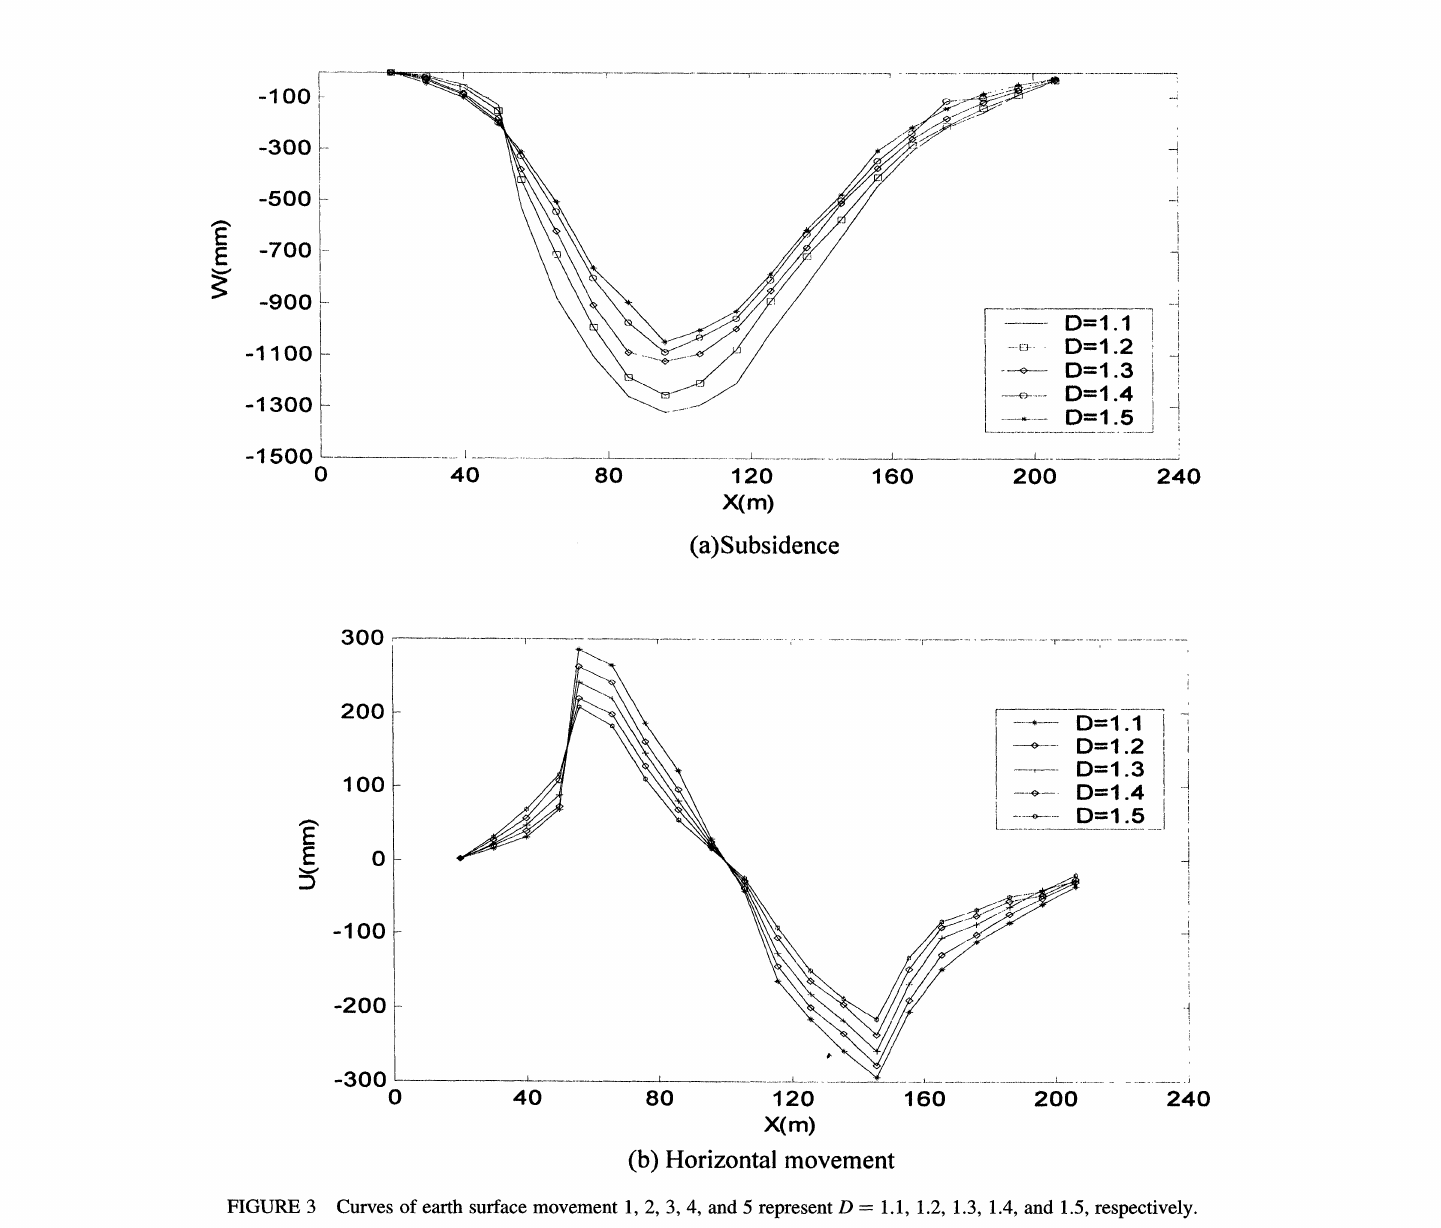
FIGURE 3 Curves of earth surface movement 1, 2, 3, 4, and 5 represent D 1.1, 1.2, 1.3, 1.4, and 1.5,